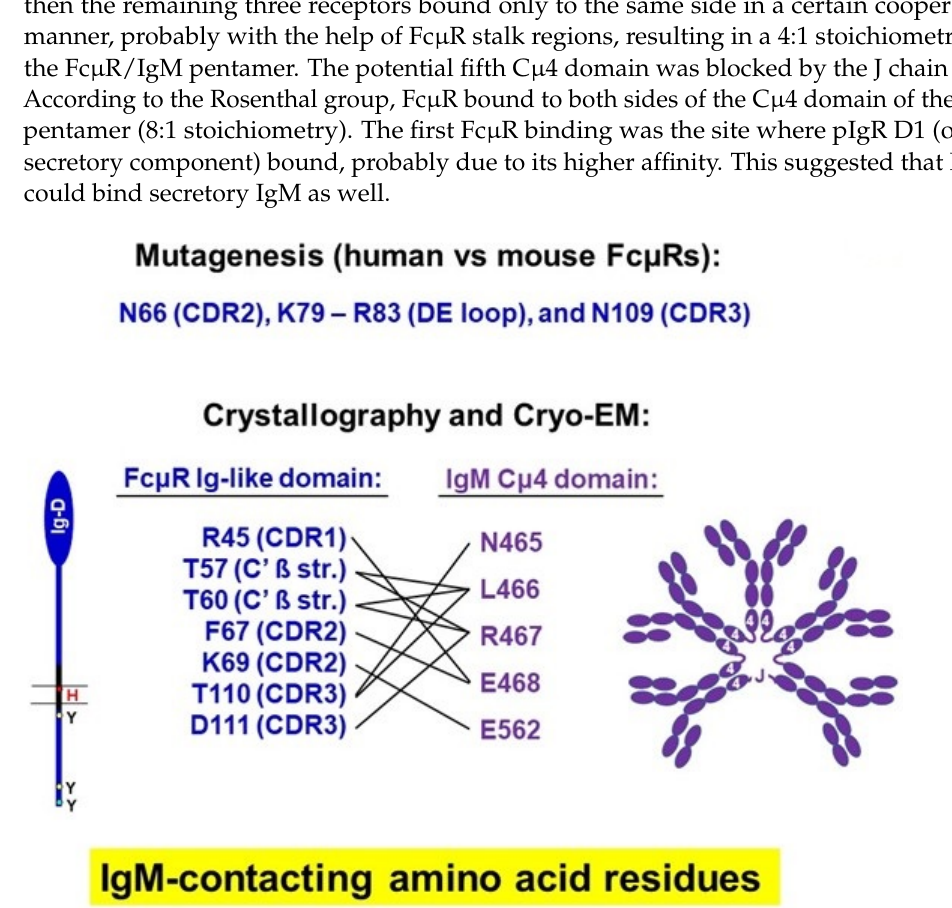
Figure 6. Identification of amino acid residues in the interaction of Fc µ R and IgM. Top: The three indicated sites are determined by site-directed mutagenesis based on the IgM-binding difference between human and mouse Fc µ Rs. Bottom: Seven different amino acid residues (single-letter codes; blue) in the Ig-like domain of FcµR are listed as critical residues for binding to the amino acid residues (purple) of the IgM Cµ4 domain, as determined by crystallographic and cryo-EM analyses. Complementary determining region (CDR) and ß strand (ß str.).